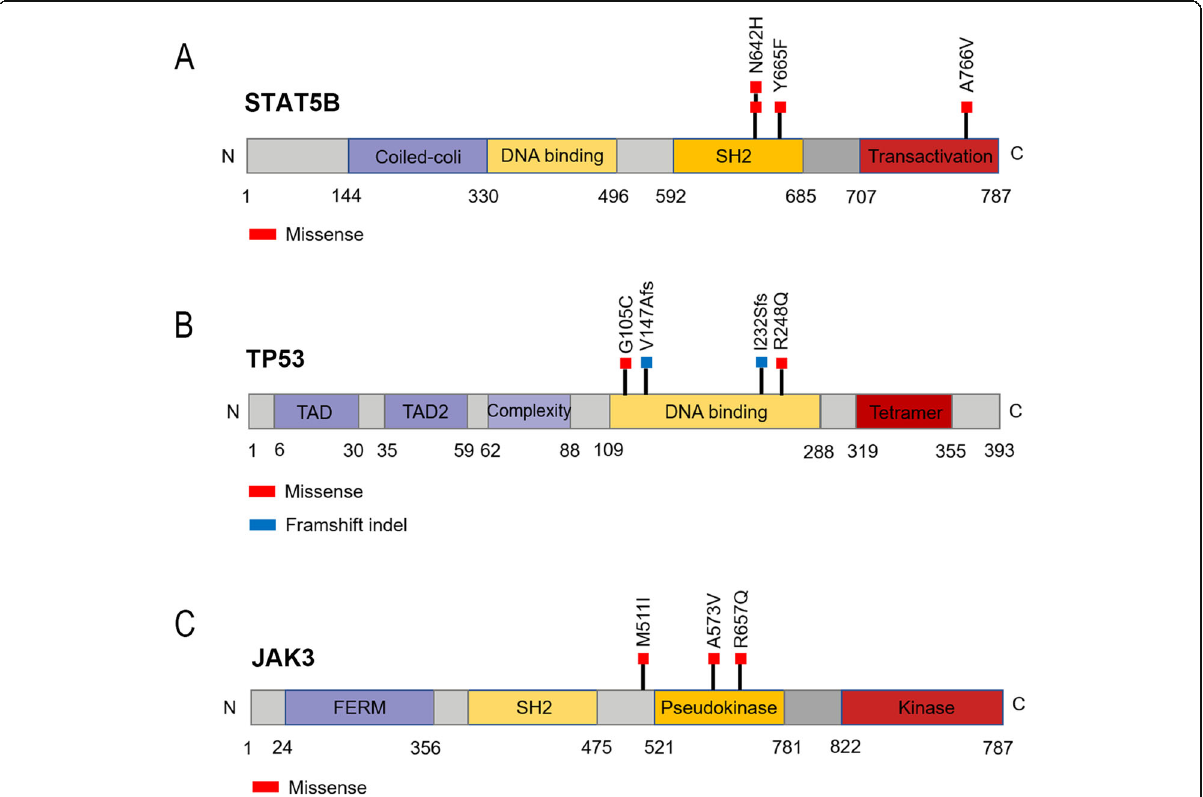
Fig. 4 Somatic alterations in STAT5B , TP53 and JAK3 identified in this study. A Four STAT5B -mututed cases harbored three distinctive missense variants, including the common N642H mutation(rs938448224) and two mutations — Y665F(COSM1716592) and A766V(COSM8916674); ( B ) Four TP53 -mututed cases harbored two frameshift variants - V147Afs*19 and I232Sfs, and two missense variants - R248Q and G105C. C Three JAK3 - mututed cases harbored three missense variants - M511I(rs752661478), A573V(COSM34215) and